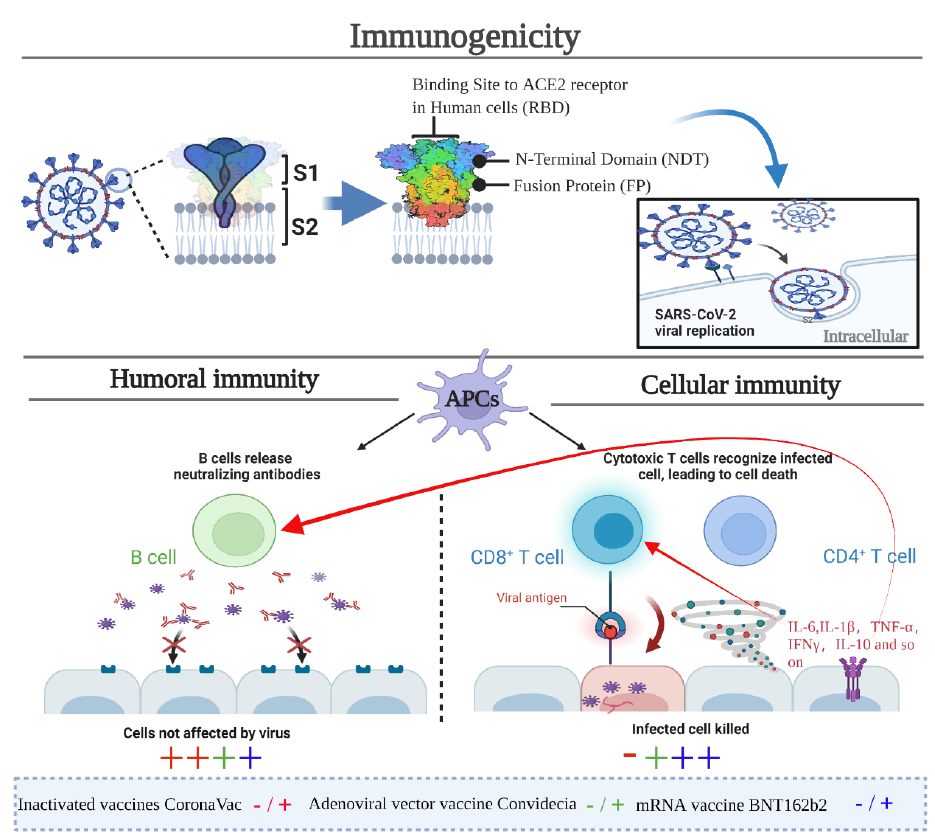
Figure 3. Illustration of immunogenicity induced by COVID-19 vaccines. Both neutralizing antibody and T cell responses are important in eradicating the virus and controlling COVID-19 development. Neutralizing antibodies exert effects by neutralizing free viruses. T cell responses are essential for directly killing virus-infected cells. In addition, CD4+ cell responses are critical for the cytotoxic T cell response and for antibody production in B cells. The intensity of immunogenicity is denoted by different colors and symbols, with red indicating CoronaVac, green indicating Convidecia, blue indicating BNT162b2, ‘−’ indicating the unreported intensity, ‘+’ indicating the intensity is moderate, and ‘++’ indicating the intensity is strong.